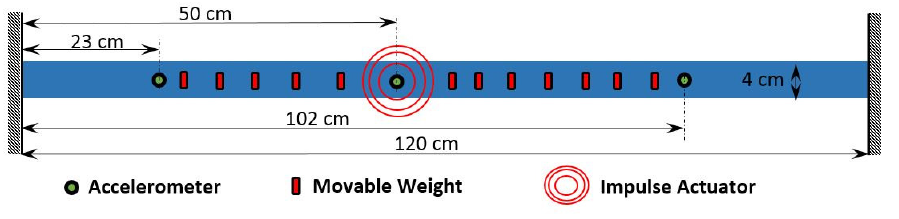
Figure 9. Schematic diagram of experimental setup [60].